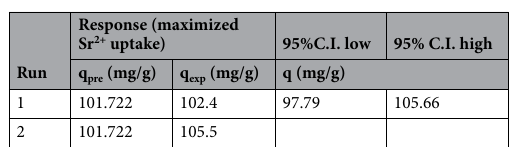
Table 5. Verification of the model at optimum condition.